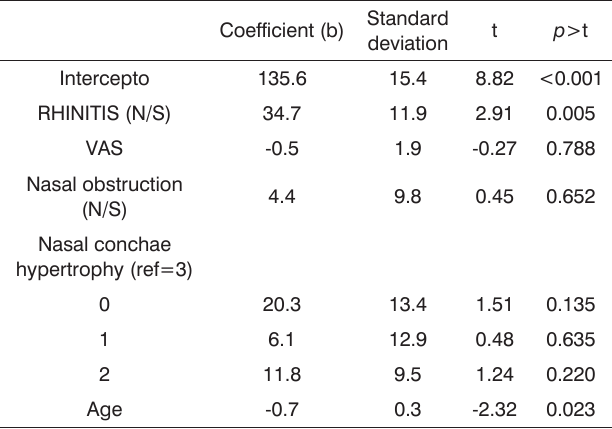
Table 5. Results from the peak-flow multiple linear